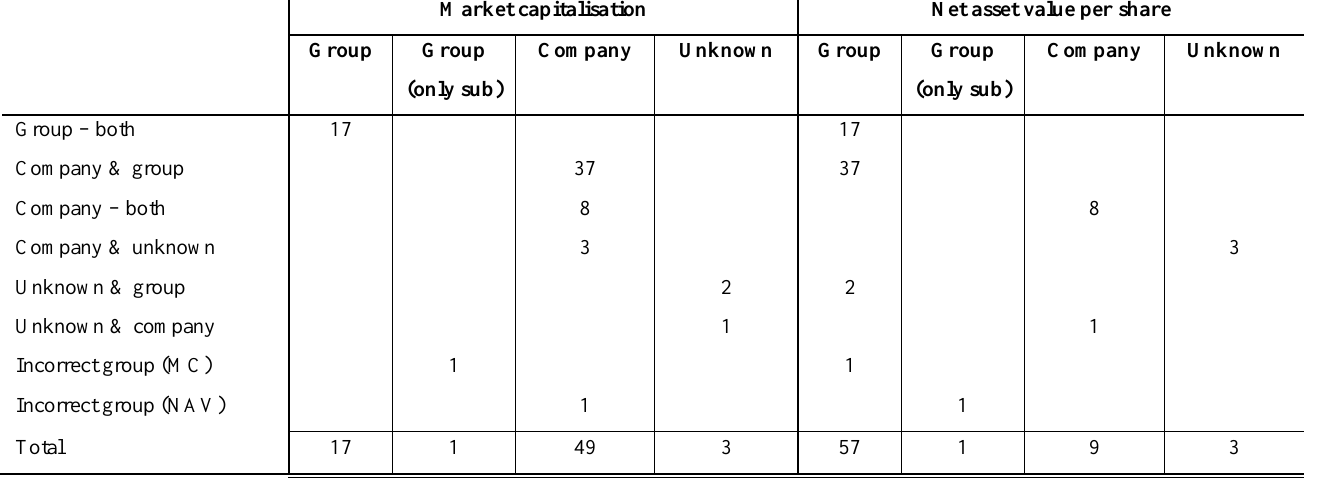
Table 1: Summary of number of shares used for market capitalisation (MC) and net asset value per share (NAV)